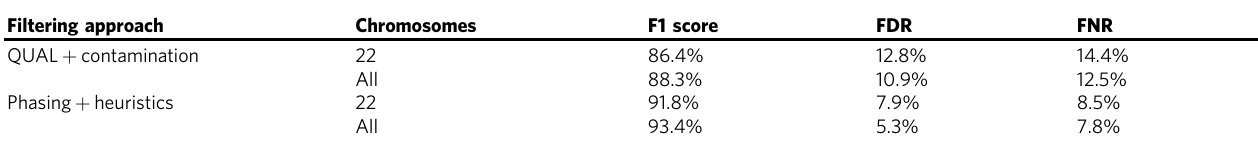
Table 1 SNV discovery and fi ltering Filtering approach